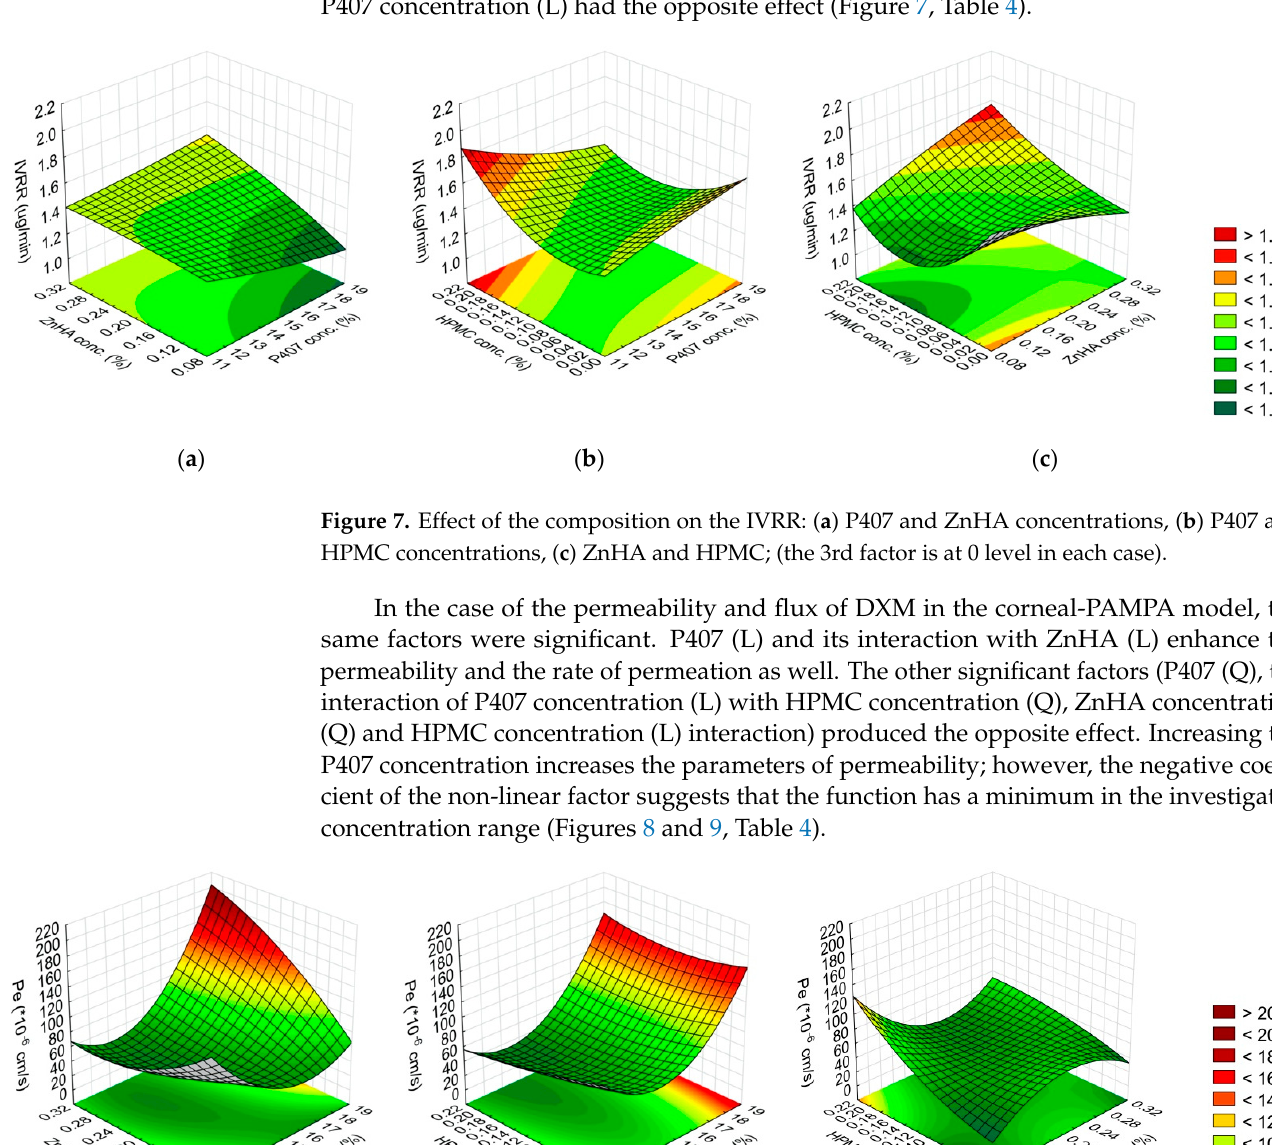
Figure 6. Effect of the composition on the released drug amount ((Q)-6 h): ( a ) P407 and ZnHA con- centrations, ( b ) P407 and HPMC concentrations, ( c ) ZnHA and HPMC; (the 3rd factor is at 0 level in each case). The IVRR of DXM from the samples was directly proportionally influenced by the concentration of P407 (Q) and the interaction of HPMC concentration (L) with the ZnHA concentration (L). In contrast, the HPMC concentration (Q) and its interaction with the P407 concentration (L) had the opposite effect (Figure 7, Table 4).